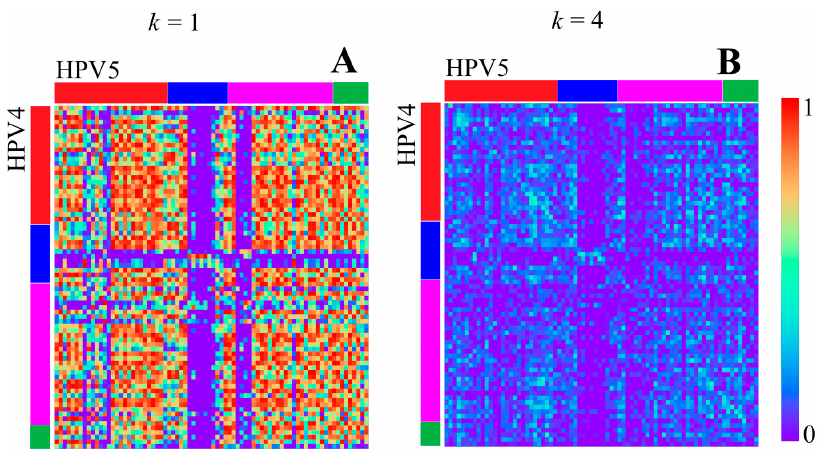
Figure 3. Correlation heatmaps between HPV4 and 5 for k = 1 ( A ) and k = 4 ( B ) (bin width of 100 bp). The colored bars at the edges indicate the locations of the top region ( red ), central region ( blue ), bottom region ( magenta ), and NC region ( green ) according to gene annotation borders (not by k -mer content).